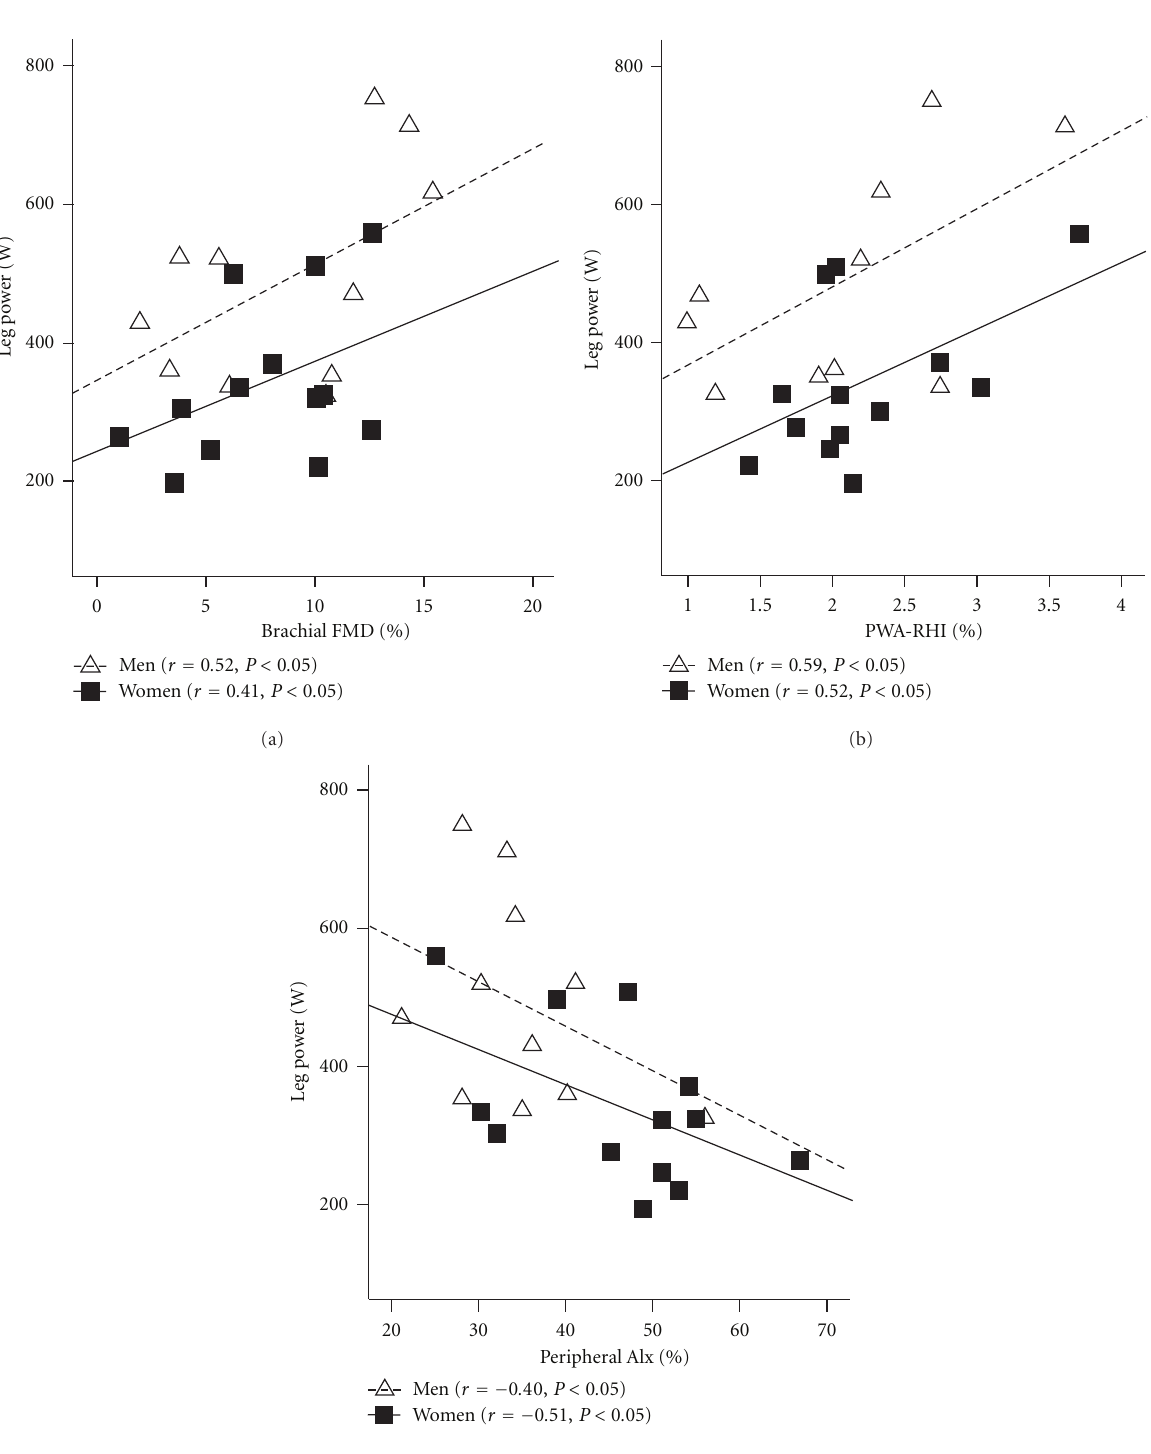
Figure 1: Association between leg power (assessed as 5 repetitions performed as fast as possible at 40% 1RM) and (a) brachial artery flow- mediated dilation (FMD); (b) pulse wave amplitude-reactive hyperemia index (PWA-RHI); (c) peripheral augmentation index (AIx). Open triangles with dashed line (men); closed squares with solid line